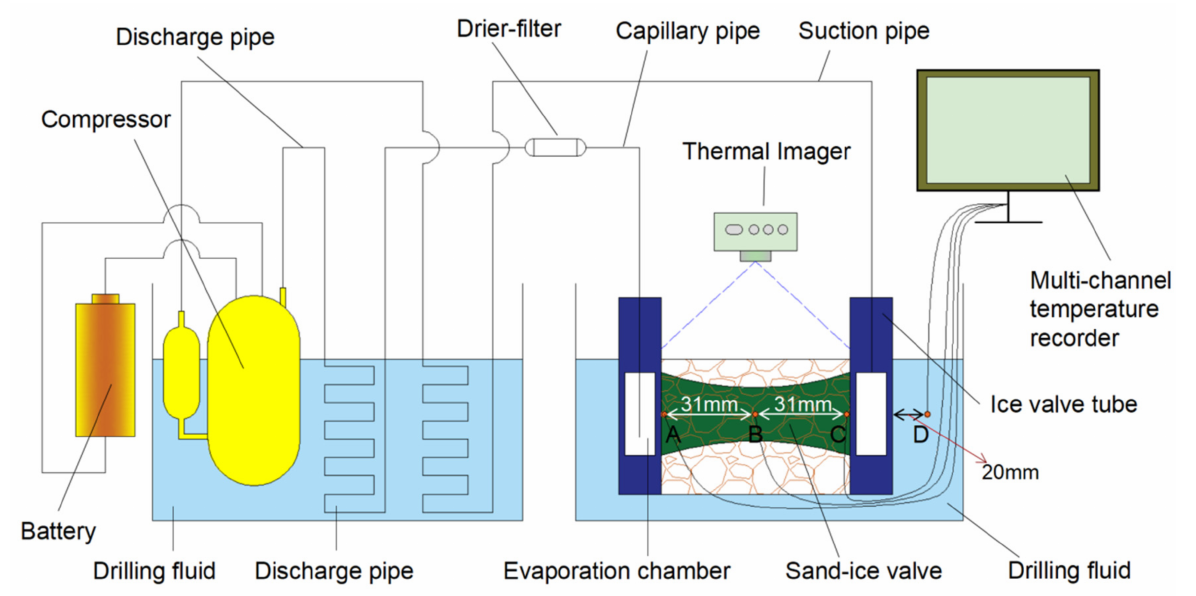
Figure 3. Schematics of the experimental